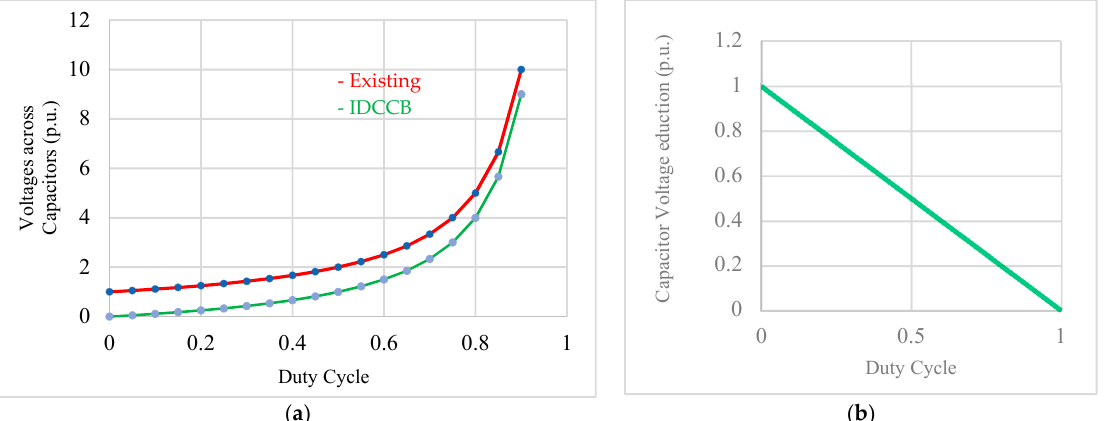
Figure 5. Capacitor voltage profiles ( a ) p.u. capacitor voltages [16] and ( b ) Reduced p.u. stresses on capacitors in existing and proposed IDCCB (the base value is the input voltage).